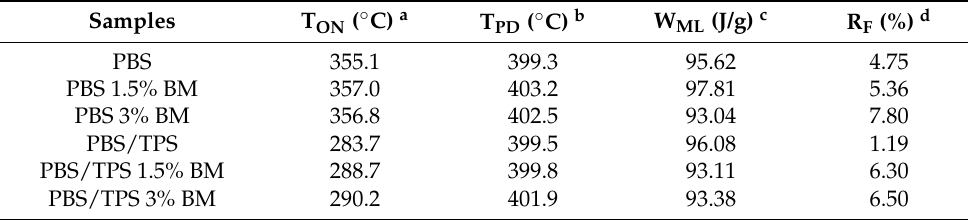
Figure 3. ( a ) TGA and ( b ) DTG curves of PBS films. Table 2. TGA data of PBS films. Table 2. TGA data of PBS